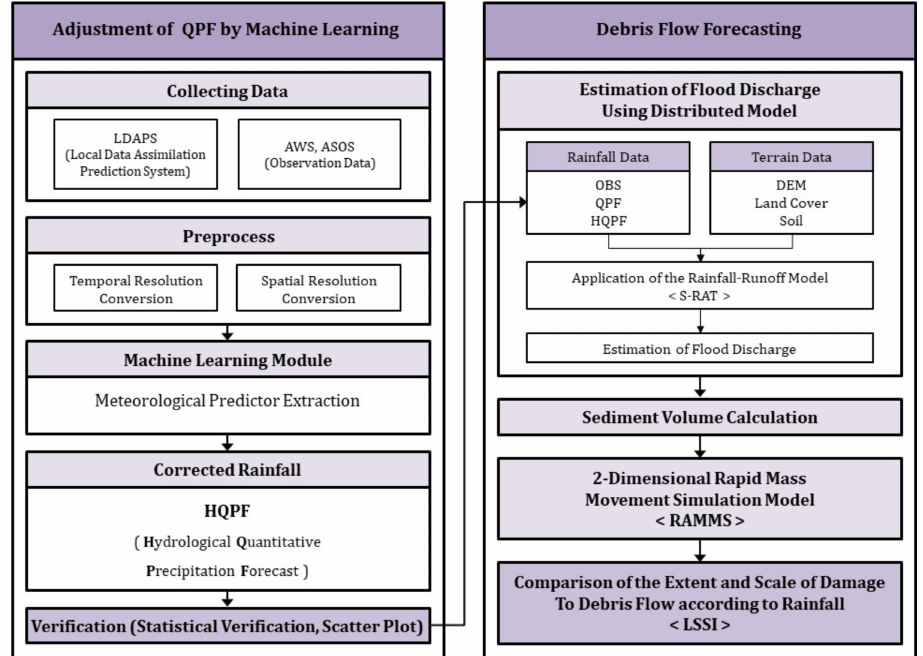
Figure 1. Research flow chart of hydrological cycle change in North